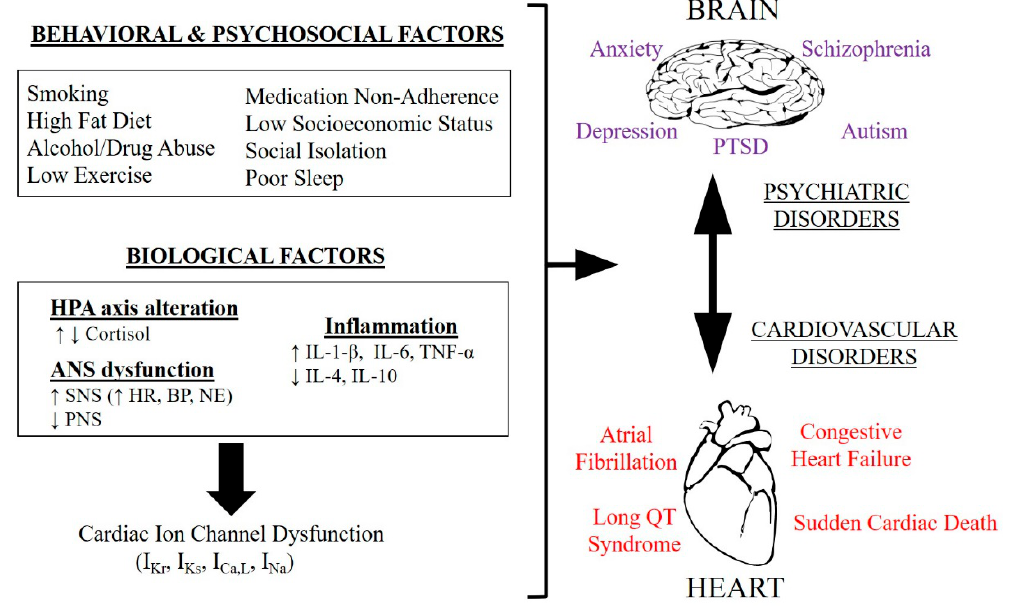
Figure 1. Functional interaction between brain and heart disorders. Scheme of the behavioral, psychosocial and biological risk factors shared among psychiatric disorders that are involved in the increased incidence of cardiovascular diseases. HPA axis = Hypothalamic–Pituitary–Adrenal axis, ANS = Autonomic Nervous System, SNS = Sympathetic Nervous System, PNS = Parasympathetic Nervous System, HR = Heart Rate, BP = Blood Pressure, NE = Norepinephrine, TNF- α = Tumor Necrosis Factor Alpha, PTSD = Post-Traumatic Stress Disorder, I Kr = Rapid Delayed Rectifier Potassium Current, I Ks = Slow Delayed Rectifier Potassium Current, I Ca,L = L-Type Calcium Current, I Na = Sodium Current, ↑ increased, ↓ decreased.